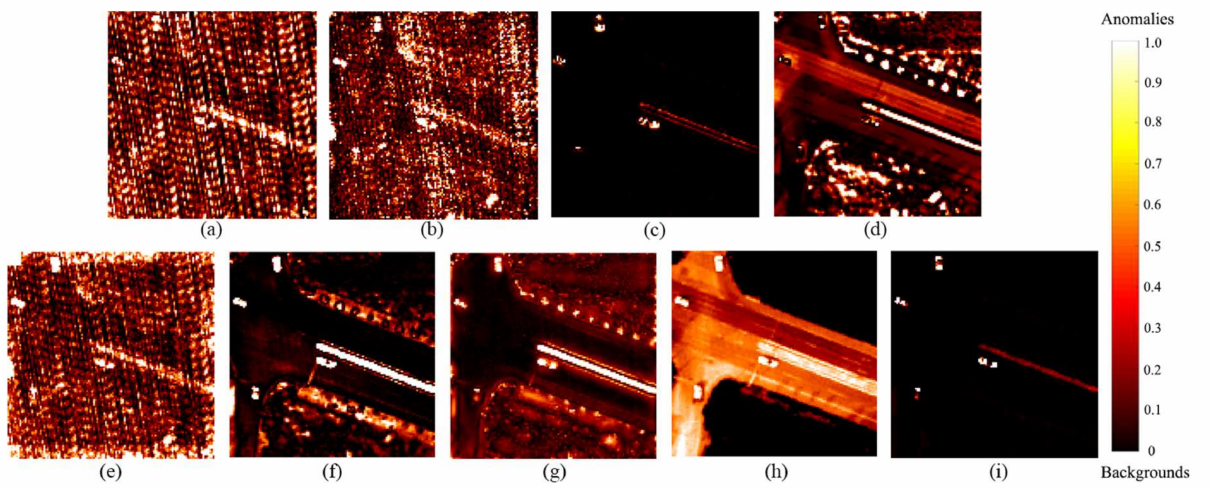
Figure 13. Detection results of the various algorithms for the Xiong’an Image: ( a ) RX, ( b ) LRX, ( c ) KRX, ( d ) SSRX, ( e ) CRD, ( f ) LSMAD, ( g ) GTVLRR, ( h ) PRLRaSAD, and ( i )